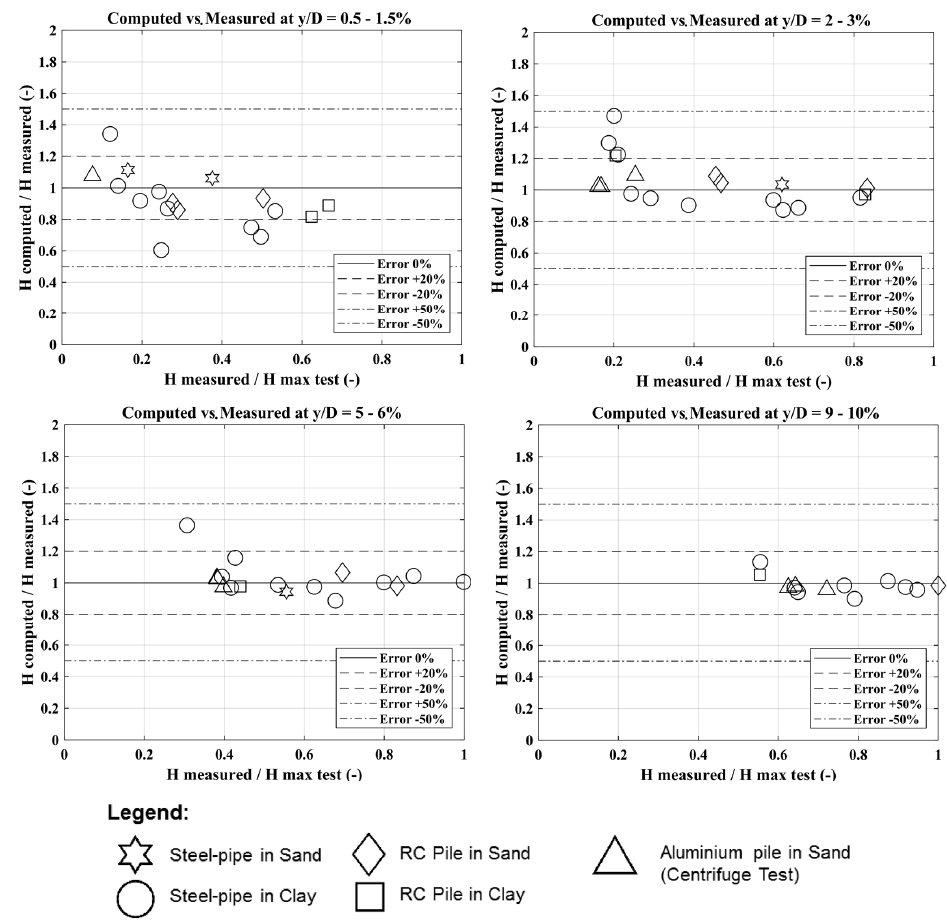
Figure 8. Comparison of measured and computed horizontal loads at the same displacement level: y / D = 0.5–1.5%; y / D = 2–3%; y / D = 5–6%; y / D = 9–10%.